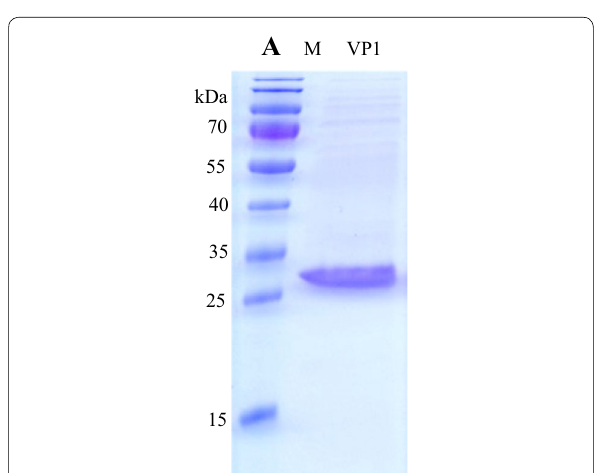
Fig. 4 An image of a 15% polyacrylamide gel showing recombinant VP1 protein that was extracted, isolated and refolded, resulting in 73% pure protein. Loaded in lane M is the PageRuler TM Prestained Protein Ladder (Thermo Fischer